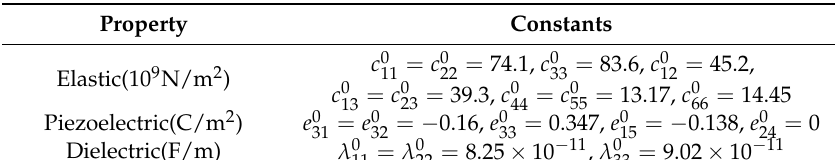
Table 1. Material constants.